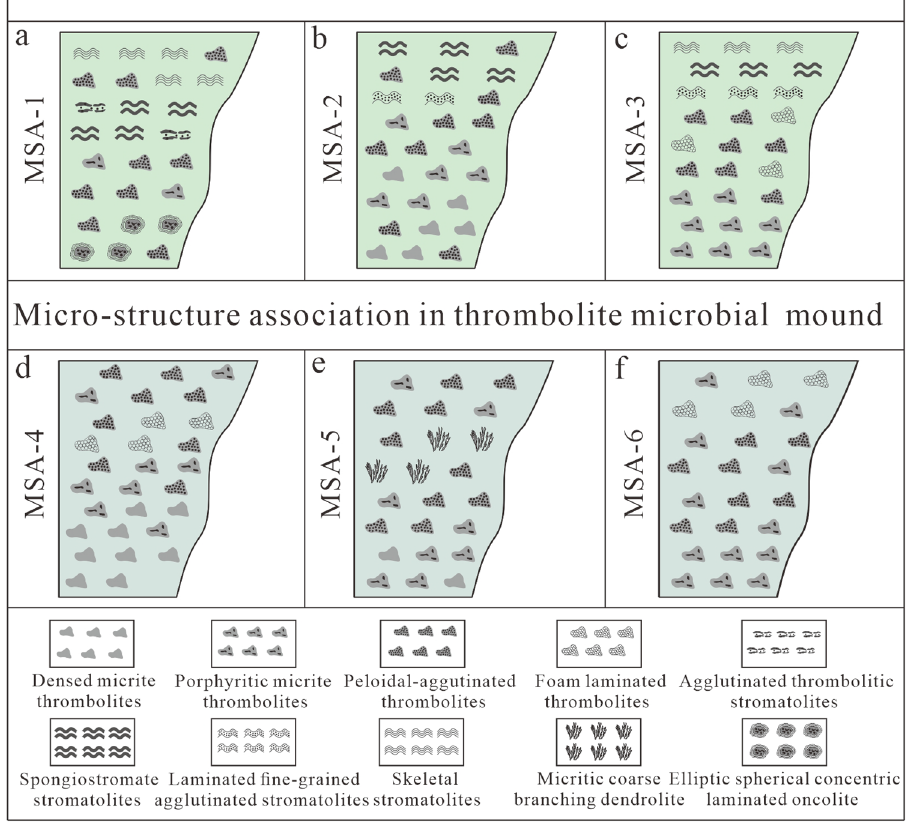
Figure 5. Characteristics of microbial micro-structure association in the Leikoupo Formation in Western Sichuan